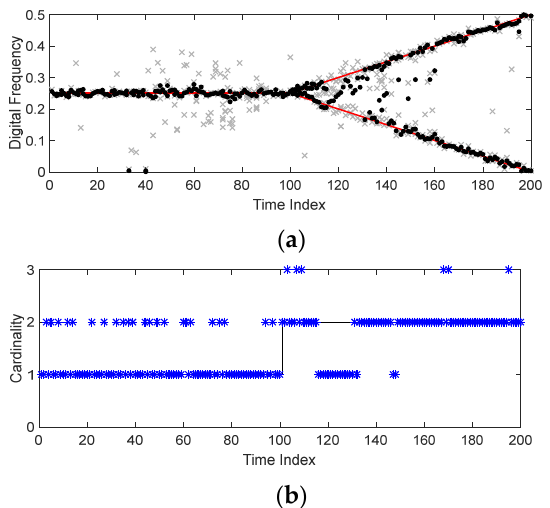
Figure 3. True trajectory (case 2): ( a ) Measurement and clutter; ( b ) Cardinality.